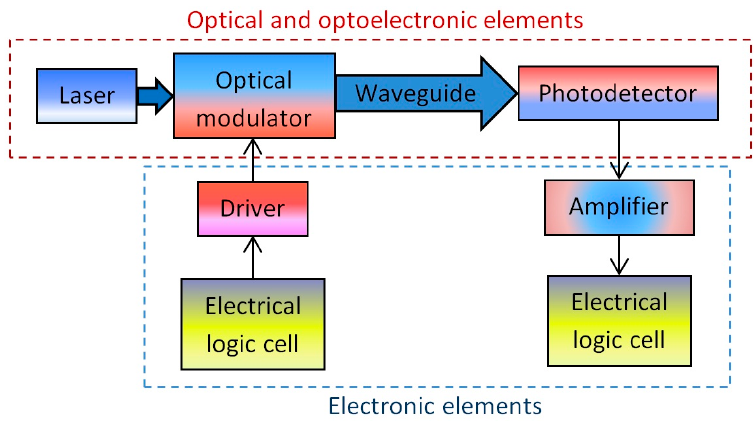
Figure 1. The structure chart of typical on-chip optical interconnection.